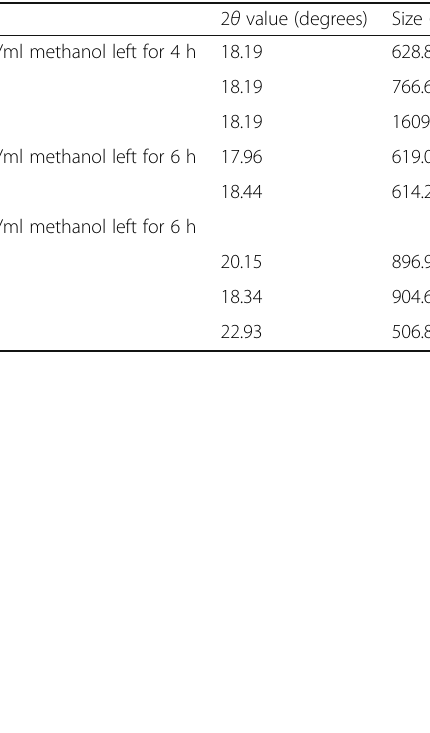
Table 5 Crystallite size obtained using the cooling method